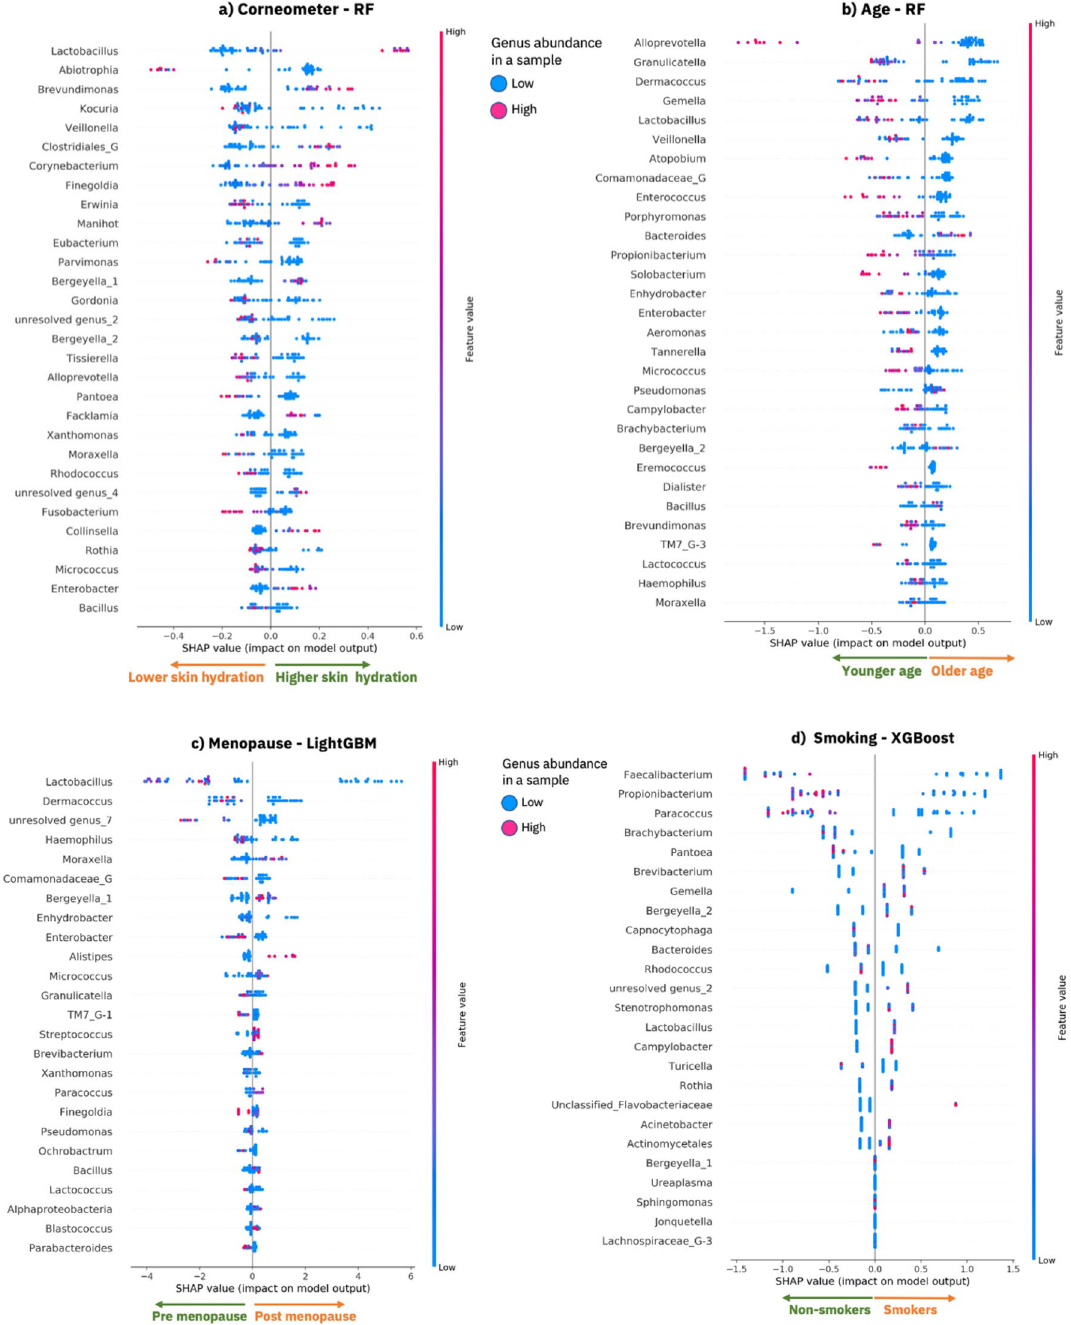
Figure 2. Model explanations for the 62 first samples taken from the Canada cohort. SHAP summary dot plot as computed by SHAP using the best optimized ML model that has been trained on 80% of the training data. Each plot provides an overview of which features are most important for a model and visualizes how the value of each feature (i.e., the genus abundance in the samples) contributes, either positively or negatively, to the prediction of phenotypic values; ( a ) lower or higher corneometer measurements, ( b ) lower or higher values of age, ( c ) pre-menopausal or post-menopausal status and ( d ) non-smokers or smokers. The features are sorted by the sum of the absolute SHAP values over all the samples in the training dataset. Each dot is a sample, and its color represents a feature value (i.e., genus abundance) for the sample. Red dots are samples for which a genus (row) is enriched, while blue dots are samples for which a genus is lower in abundance. Clusters of red samples on the right side of the x-axis means that the genus is abundant in those samples and it is contributing to the prediction of a higher phenotypic value (indicated by the x-axis annotation of arrows pointing right). Clusters of red samples (dots) on the left side of the y-axis means that the genus is enriched for those samples and it is contributing to the prediction of a lower phenotypic value for those samples (indicated by the x-axis annotation of arrows pointing left). This image was created using SHAP 20 version 0.34.0 (https ://githu b.com/slund berg/